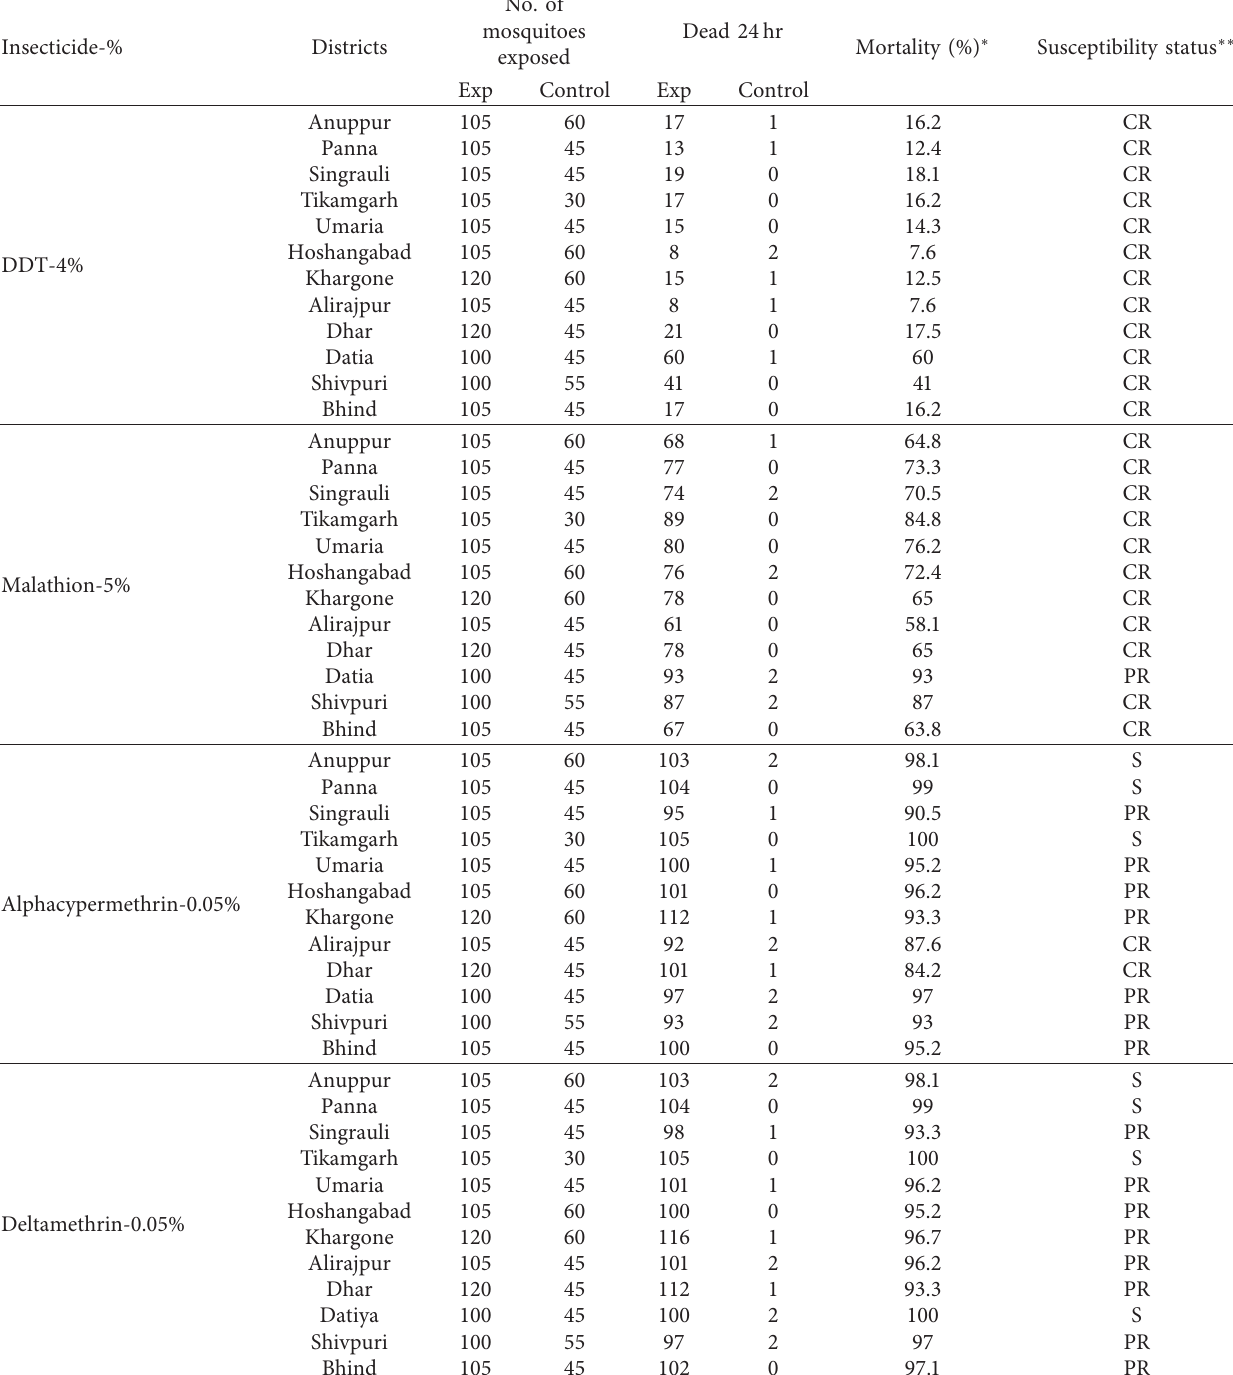
Table 3: Susceptibility status of An. culicifacies to discriminatory dosages of DDT, malathion, alphacypermethrin, and deltamethrin in 12 districts of Madhya Pradesh. Insecticide-% Districts